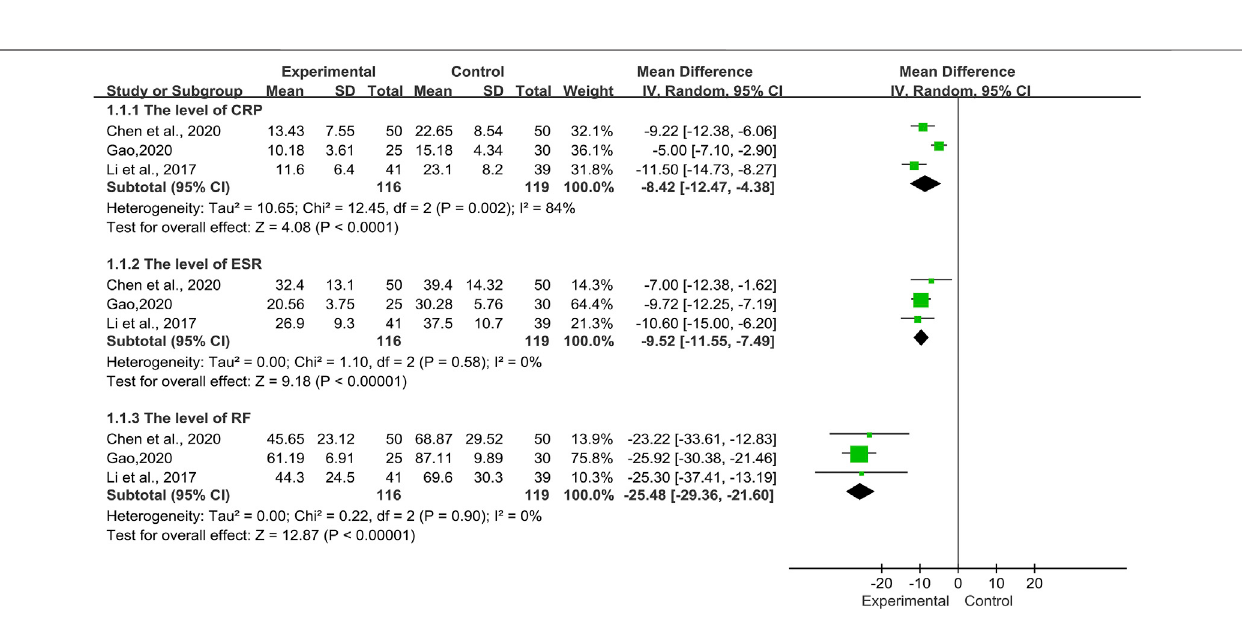
Frontiers in Pharmacology |